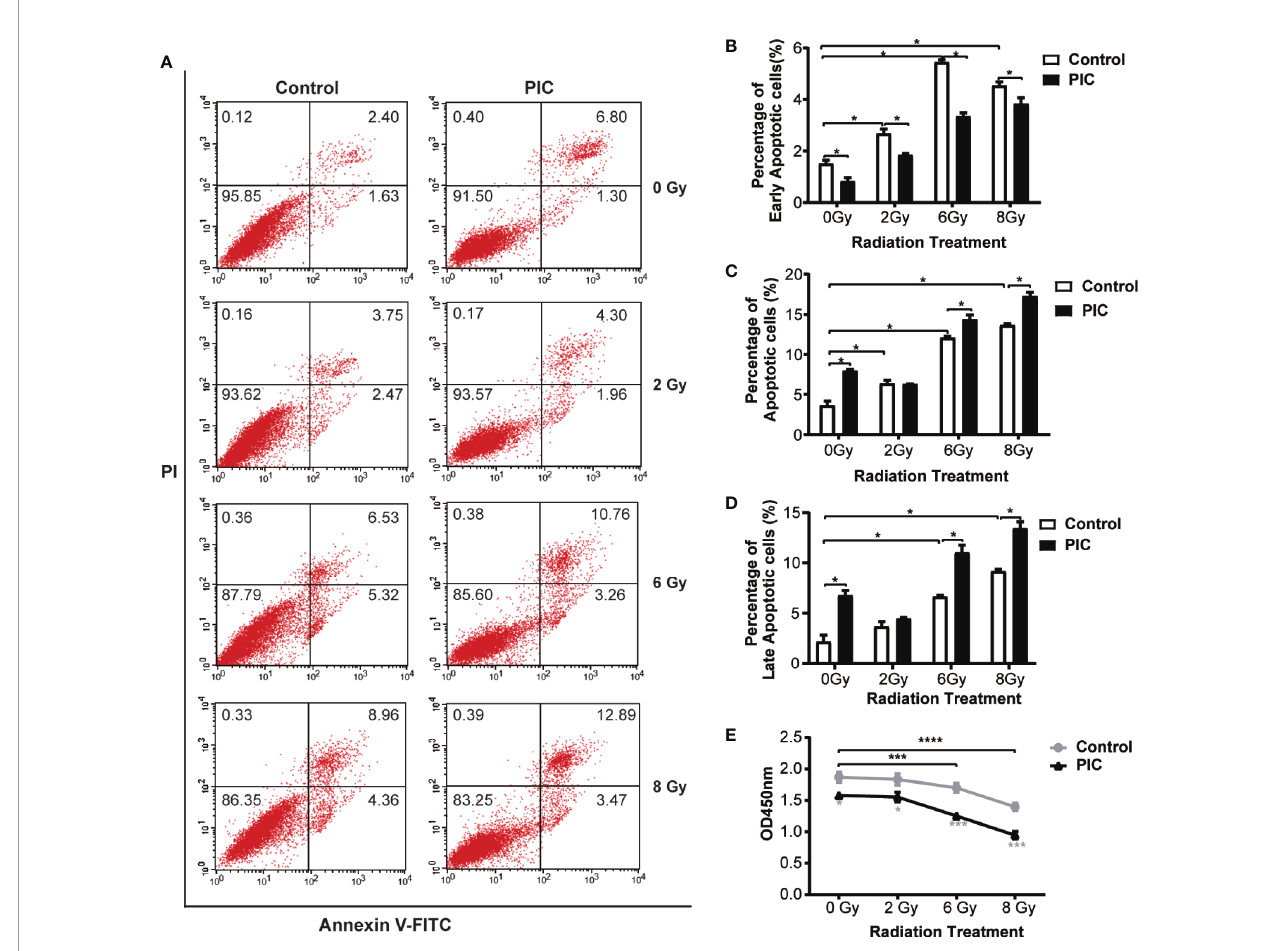
FIGURE 6 | Poly(I:C) enhances radiation-induced apoptosis and inhibits proliferation of CAL-27. CAL-27 cells were treated with poly(I:C) or PBS for 24 h followed by radiation. (A) Representative plots illustrate apoptosis of CAL-27 according to annexin V and/or propidium iodide (PI) staining. (B) Bar plots indicate the quanti fi cations of early apoptotic cells ((annexin V+/PI-) of the bottom right quadrant. (C) Bar plots indicate the quanti fi cations of late apoptotic cells (annexin V+/PI+) of the top right quadrant. (D) Bar plots indicate the quanti fi cations of total apoptotic cells (annexin V+) of the top right and bottom right quadrants. (E) The proliferation curve shows the proliferation of CAL-27 detected by CCK-8 assay. Student ’ s t-test was used for signi fi cance determination of fl owcytometry (mean ± SD, n = 3). ANOVA was used for signi fi cance determination of CCK-8 assay (mean ± SD, n = 5). * indicates P < 0.05, *** indicates P < 0.001 and **** indicates P < 0.0001. PIC, poly